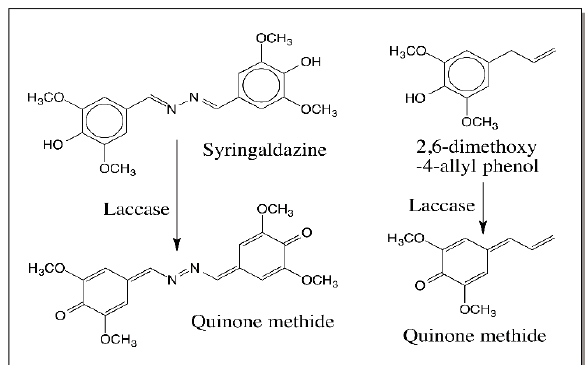
Figure 10. Laccase catalyzed quinone methide production from 4-alkyl phenols. Laccase produces